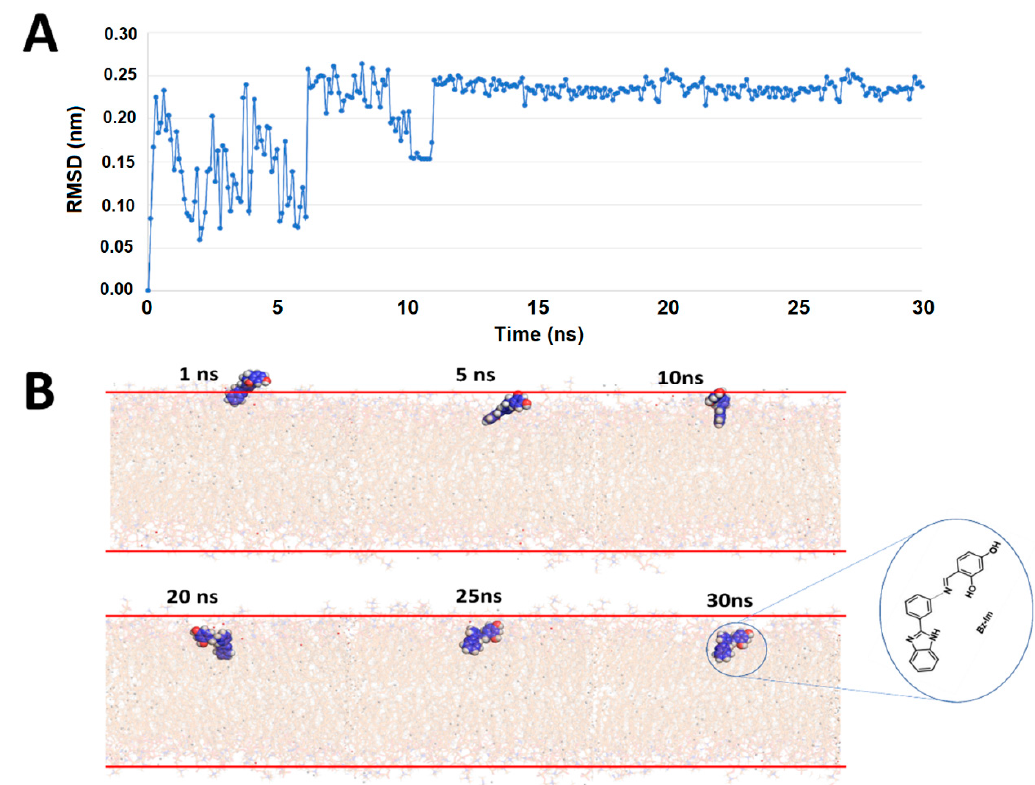
Figure 2. Behavior of Bz-Im in the erythrocyte membrane model system for 30 ns. ( A ) Root mean square deviation (RMSD) of Bz-Im in the erythrocyte membrane system at 30 ns. ( B ) Bz-Im movement from the surface of the erythrocyte membrane during the 30 ns.